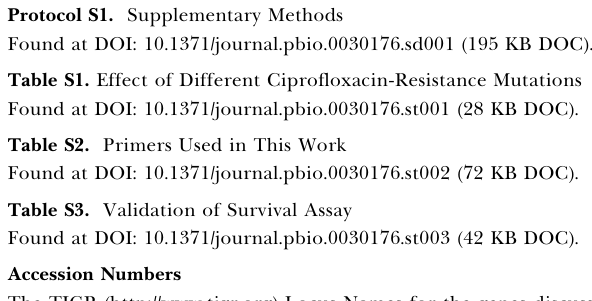
Figure S4. Reconstruction of Mutants by Replica Plating